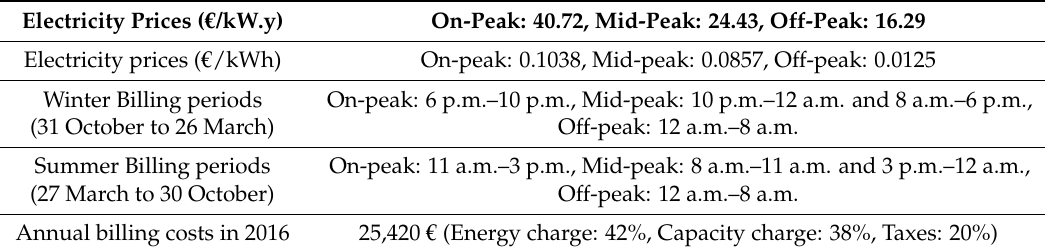
Table 4. Billing structure and billing costs for commercial consumer in Spain. Electricity Prices ( €